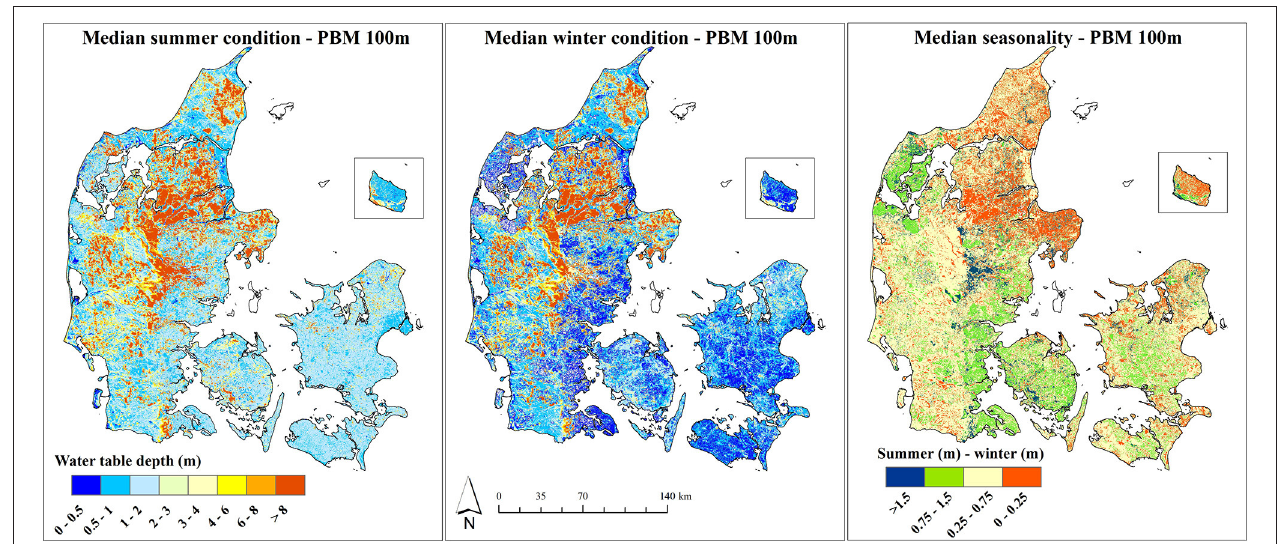
FIGURE 2 | Simulation results for the depth of the uppermost water table from a national physically-based model (PBM) at 100m spatial resolution: The left panel shows the simulated median summer condition (JJA). The center panel shows the simulated median winter condition (DJF). The right panel depicts the median seasonality, calculated as summer minus